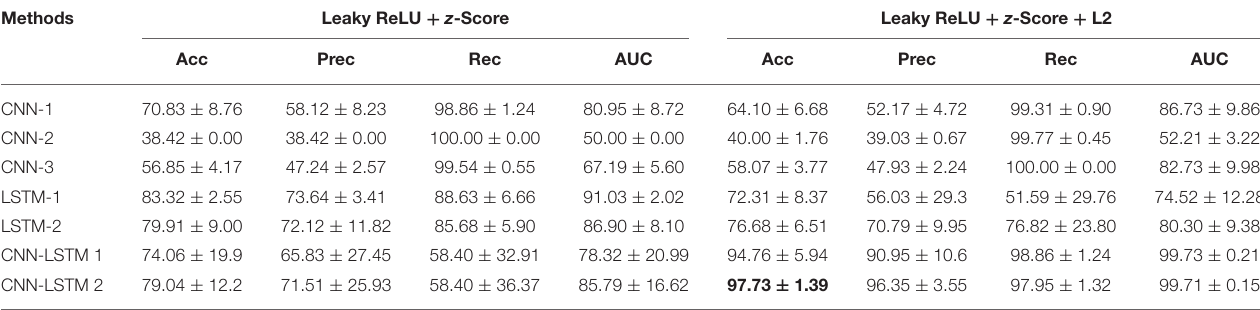
TABLE 10 | Performance criteria of the proposed DL methods with Leaky ReLU activation function. Methods